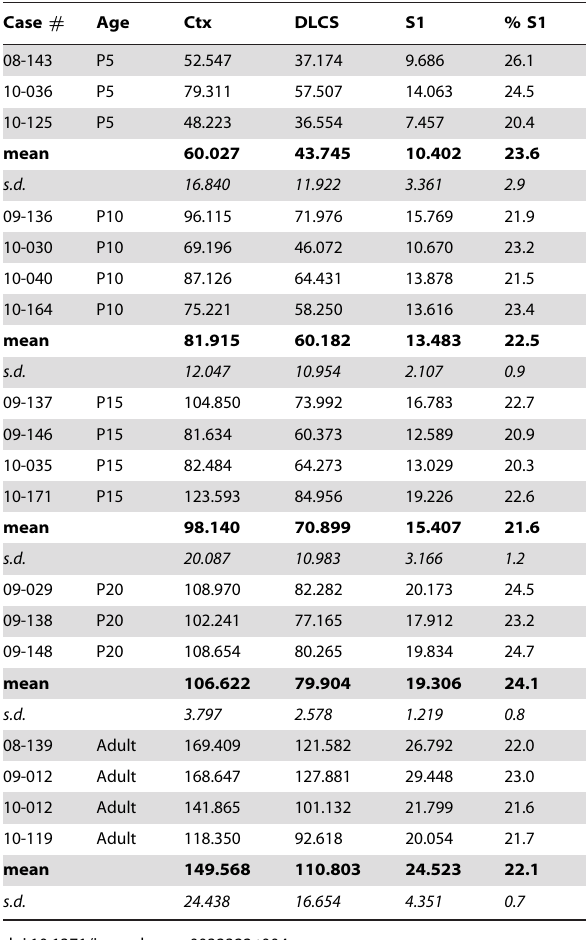
Table 4. Brain Areas in mm 2